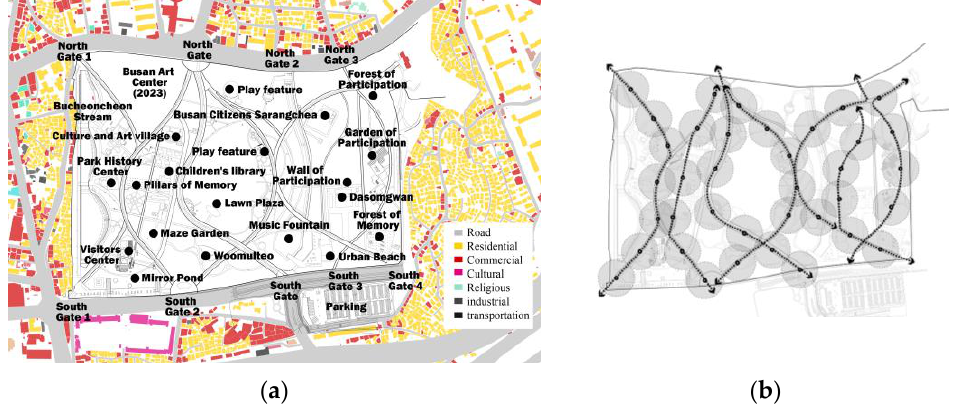
Table 3. The number of users of main spaces of the